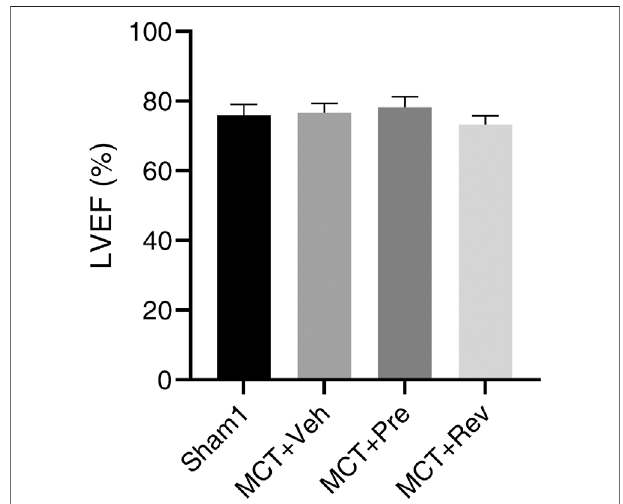
FIGURE 2 | Neither MCT or dapagli fl ozin had any effect on the LV systolic function of the rats. Short axis M-mode recordings were obtained to measure LVEF fi ve weeks after MCT injection. ( n (cid:1) 6 for Sham1, n (cid:1) 10 for MCT + vehicle, MCT + prevention, and MCT + reversal).